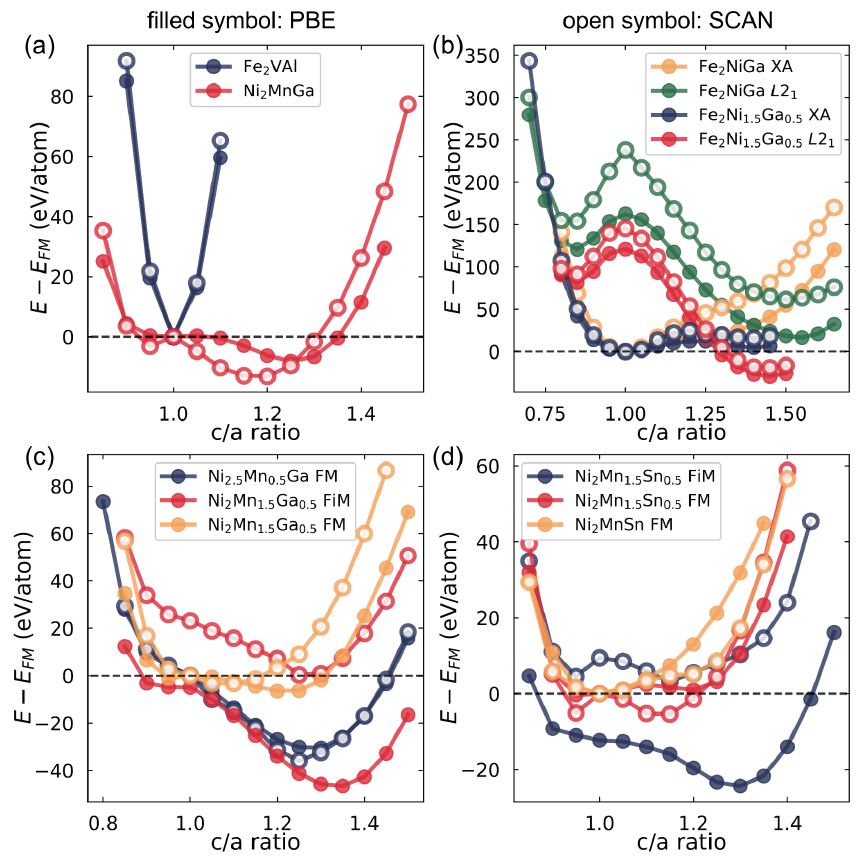
Figure 9. The calculated total-energy differences relative to the FM state as a function of the tetragonal ratio c / a for ( a ) Ni 2 MnGa and Fe 2 VAl, ( b ) Ni 2.5 Mn 0.5 Ga and Ni 2 Mn 1.5 Ga 0.5 , ( c ) Ni 2 Mn 1 + x Sn 1 − x ( x = 0 and 0.5), ( d ) Fe 2 Ni 1 + x Ga 1 − x ( x = 0 and 0.5). Results are presented for different magnetic configurations. For Fe-Ni-Ga, the energy difference is plotted relative to the FM XA structure